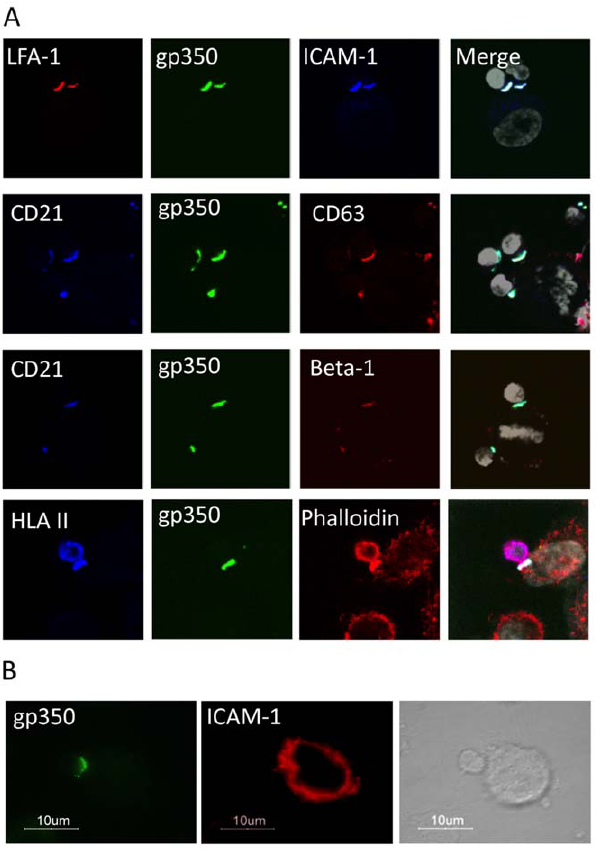
Figure 2. Analysis of B cell surface molecules at the virological synapse. (A) Confocal images of 1 m m Z slices through conjugates formed between EBV-infected B cells (24 hr p.i.) and primary tonsillar epithelial cells. Before co-culture, B cells were pre-labeled with non- blocking antibodies to virus (gp350) or cell surface molecules labeled with AlexaFluor 488 (green), 555 (red), 647 (blue) and DAPI (white). Antibodies derived from the same species were pre-labelled using the Zenon antibody-labeling kit. All gp350 staining co-localises at the cell- cell junction with the B cell surface molecules CD21, LFA-1, ICAM-1, CD63 and b -1 integrin. B cell surface HLA class II molecules are not restricted to the cell-cell junction, but are also present around the B cell surface. (B) Conjugates labelled with gp350 and ICAM-1 following co- culture showed the epithelial cell surface molecules did not relocate to the site of B cell-epithelial cell